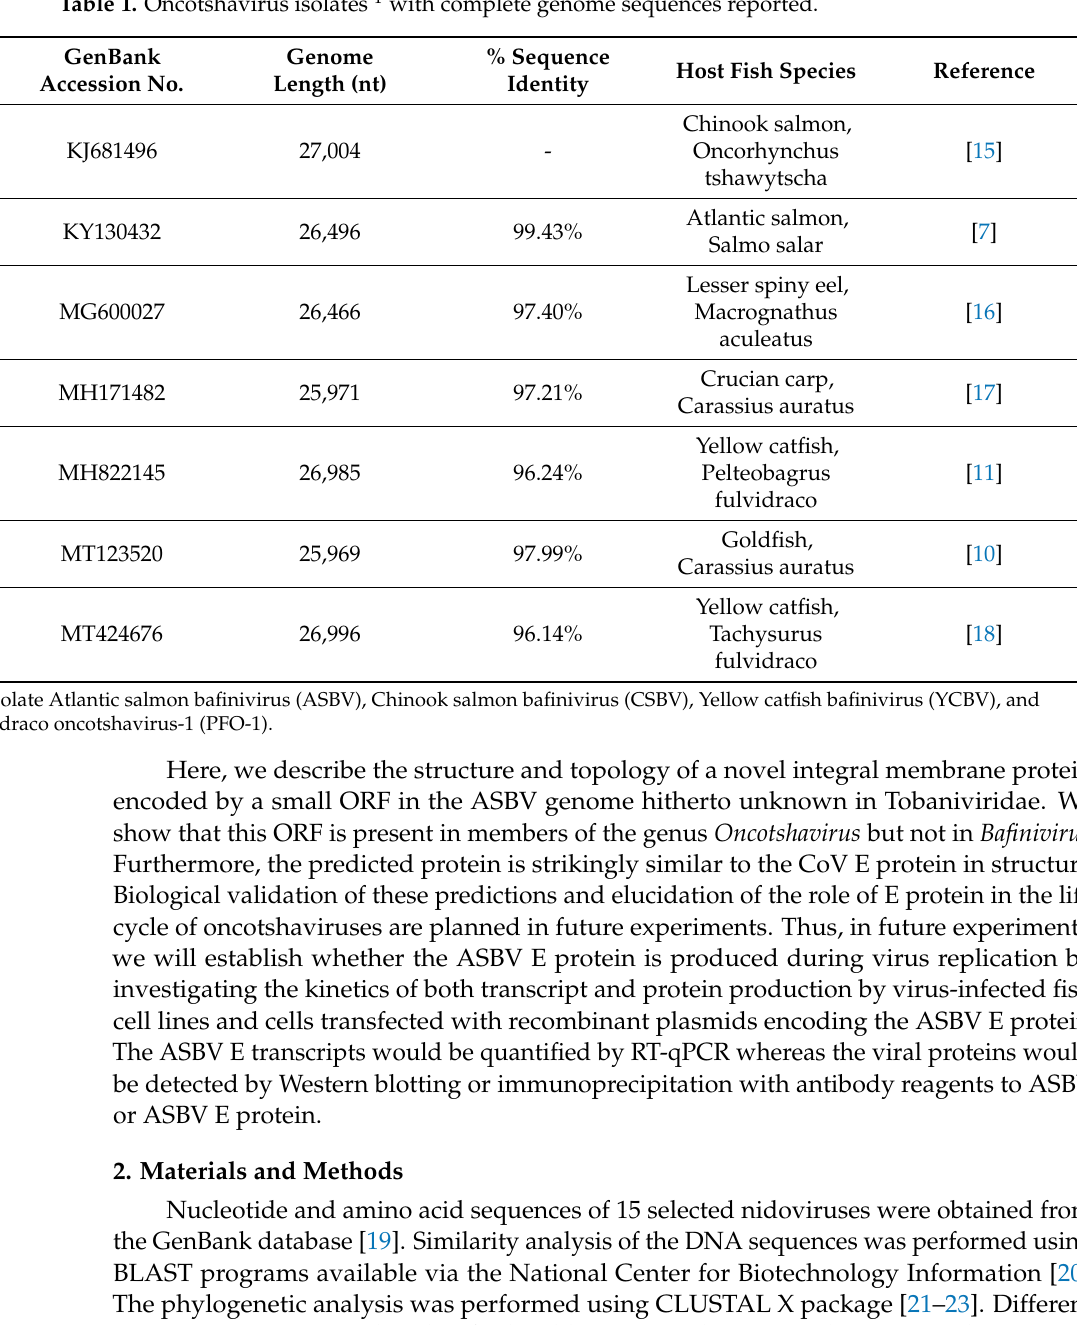
Table 1. Oncotshavirus isolates 1 with complete genome sequences